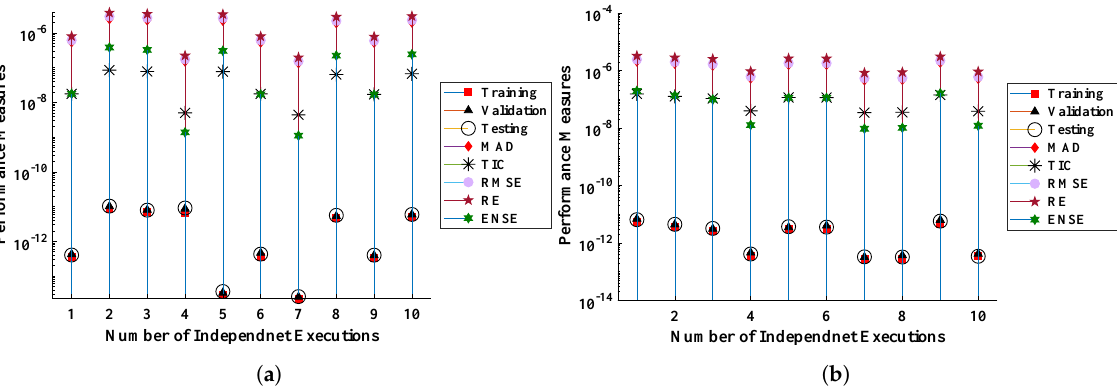
Figure 12. Detailed study of each execution of the proposed technique for the behavioral study of different performance indicators for calculating the solutions for ( a ) velocity and ( b ) acceleration of the fluid with isothermal boundary conditions.